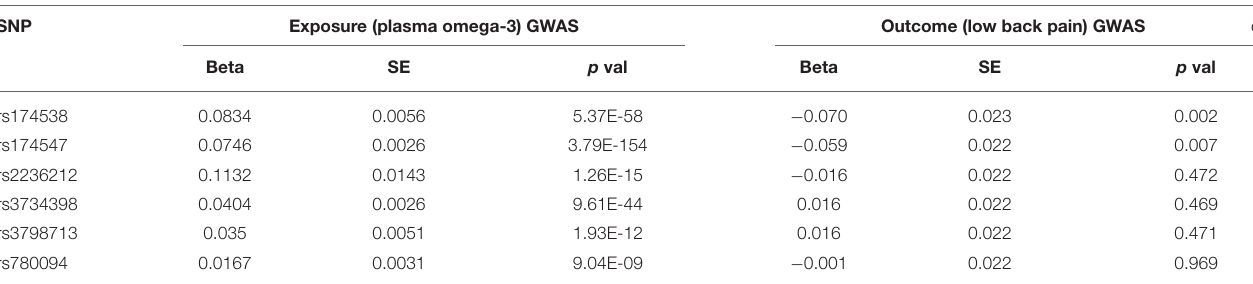
TABLE 3 | Association of plasma omega-3 genetic instrumental variables (IVs) with low back pain